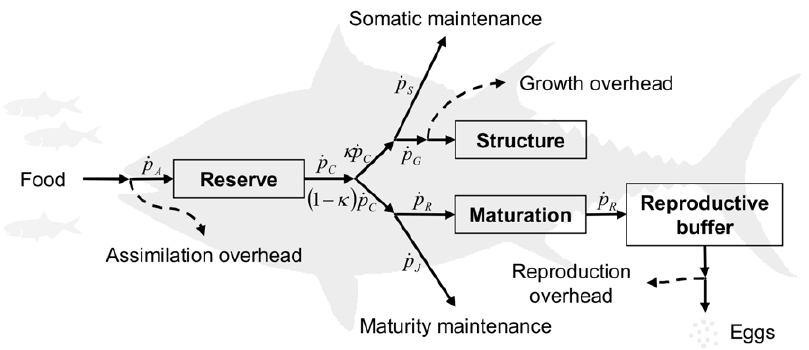
Figure 1. Schematic representation of a dynamic energy budget of Pacific bluefin tuna. Energy fluxes are defined in Table 2. See text for details.